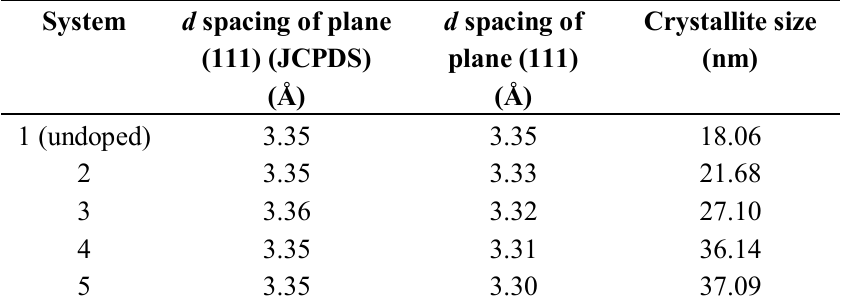
Table 1. XRD data of Sn:CdS